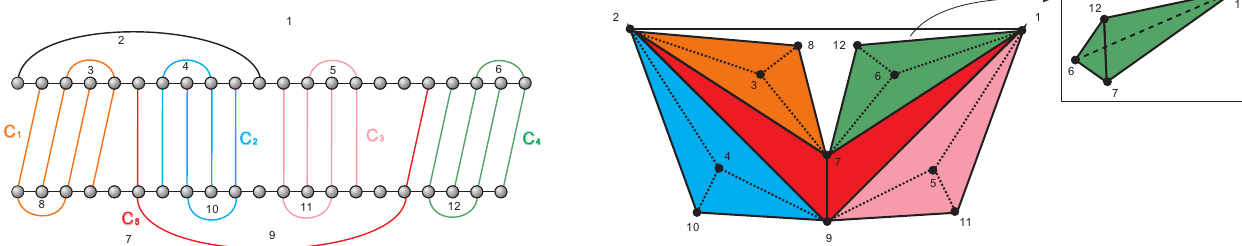
Figure 7. Components. LHS: A τ -structure I (cid:48) with labeled loops. RHS: The complex K ( I (cid:48) ) of I (cid:48) embedded in the Euclidean space R 3 . Note that K ( I (cid:48) ) is identical to ˜ X . The 2-simplices in K ( I (cid:48) ) are partitioned into five components. The insert (RHS) depicts the component in green, which is an empty